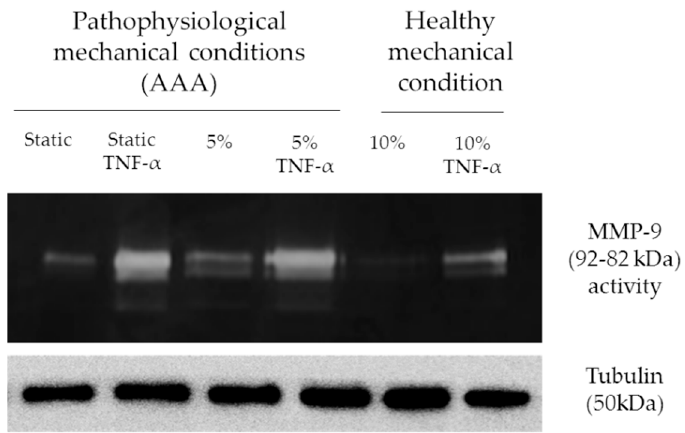
Figure 7. Strain affect MMP-9 expression and activity. Representative zymography assay to detect MMP-9 activity and expression after mechanical (5 and 10%) and chemical (TNF- α 50ng/mL) stimulation. Tubulin is used for loading control.